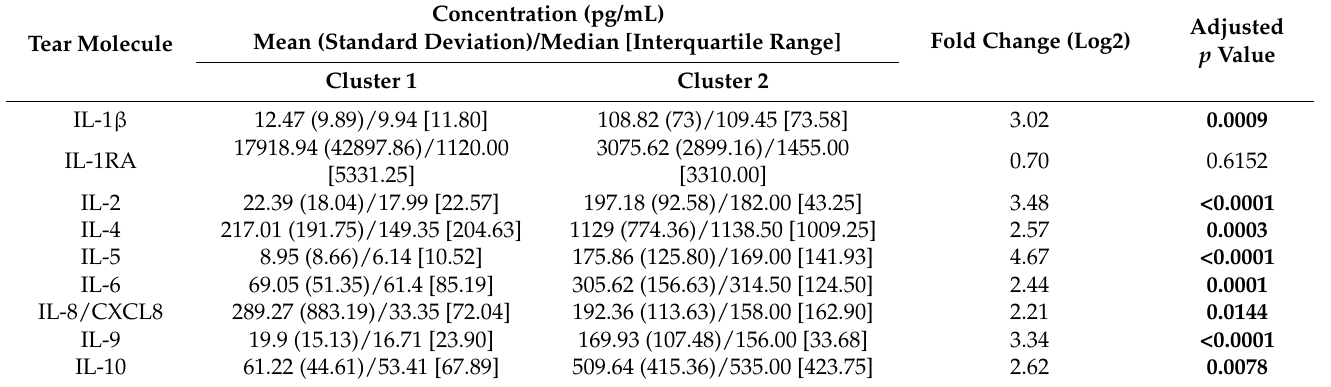
Figure 2. Fold change of tear cytokine levels in mercury-poisoned patients versus healthy controls. Tear cytokines are shown on the Y -axis. The fold change (FC) with the 95% confidence interval (CI, horizontal lines) for each cytokine is shown on the X -axis. The case: control FC was defined as the relative expression of the cytokine concentration in the patient group divided by the control group. Data on the X -axis are presented in a base 2 logarithmic (log2) scale. The vertical dashed line represents no change. The FCs were significant if the 95% CI did not cross the vertical dashed line. The farther the distance to the vertical dashed line, the greater the statistical significance. Positive values mean over-expression and negative values mean under-expression. Table 6. Cytokine concentrations in tears of patients in Cluster 1 and Cluster